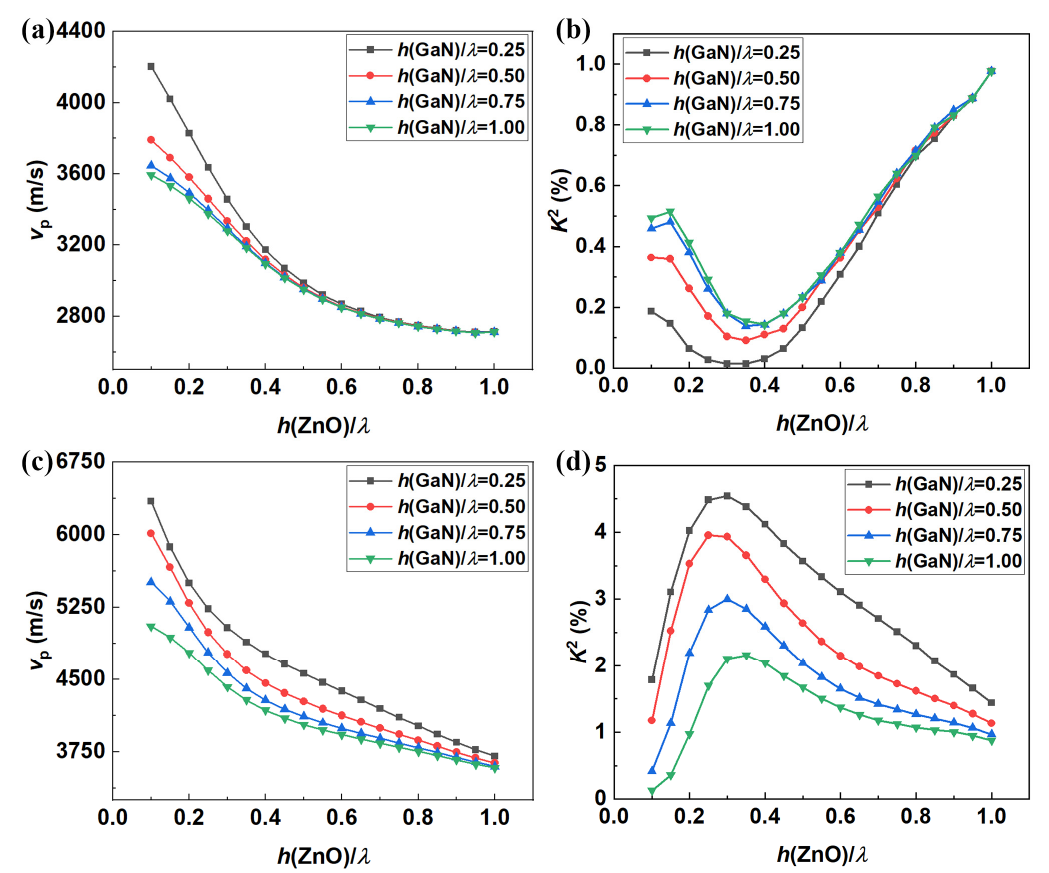
Figure 9. v p ( a ) and K 2 ( b ) of 0th mode Rayleigh wave, v p ( c ) and K 2 ( d ) of 1st mode Rayleigh wave (Sezawa-mode wave) as functions of h (ZnO) and h (GaN) in the SAW devices based on the c-ZnO/c-GaN/c-sapphire structure.